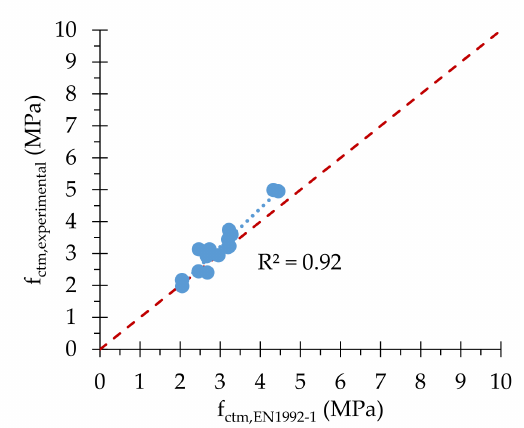
Figure 19. Comparison of the experimental tensile splitting strength at 28 days and that estimated through EN 1992-1 [42].